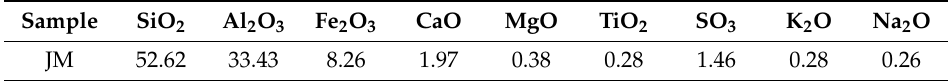
Table 2. Chemical composition of coal ash (mass %).